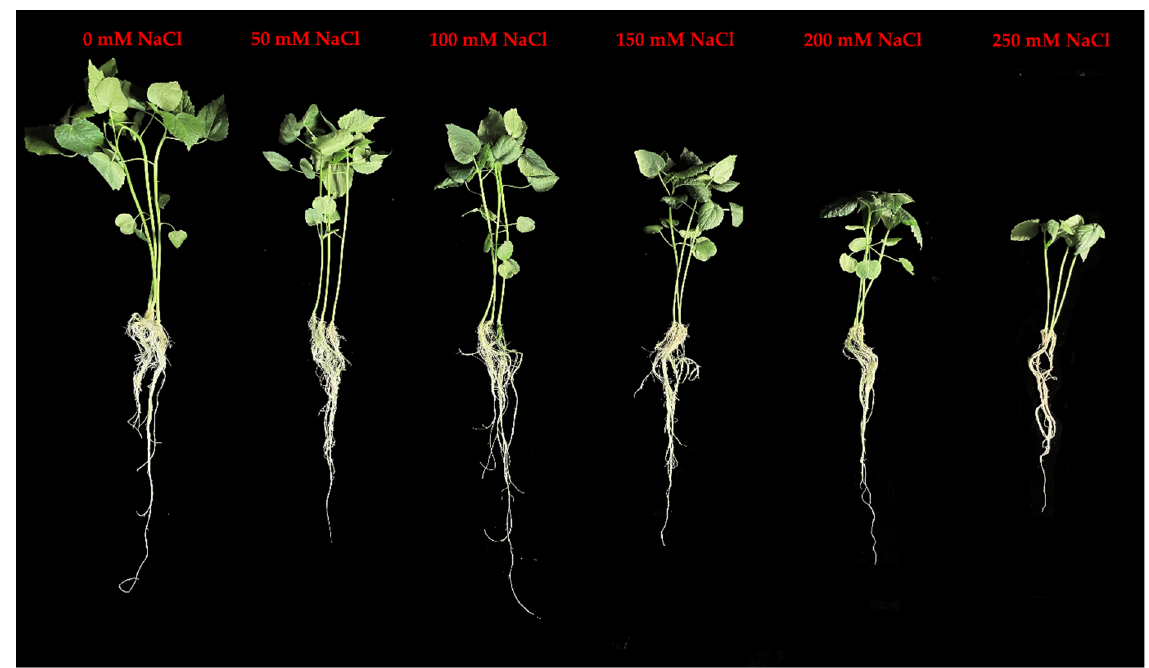
Figure 1. Changes in morphology of H. cannabinus seedlings grown under different salt stress conditions (0 mM of NaCl, 50 mM of NaCl, 100 mM of NaCl, 150 mM of NaCl, 200 mM of NaCl, and 250 mM of NaCl).